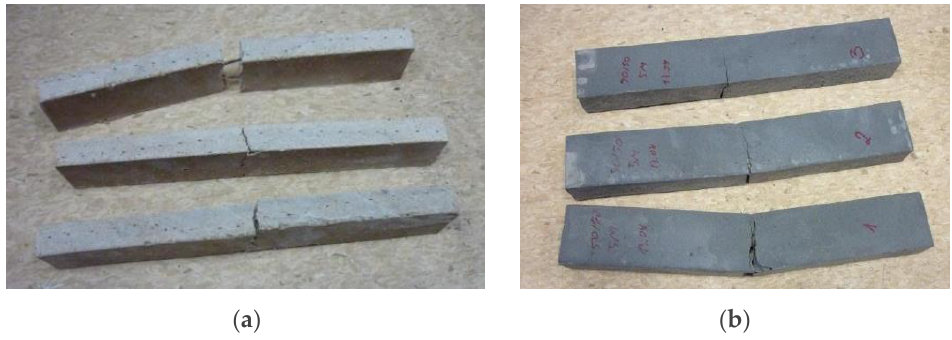
Figure 18. Geopolymer samples after the flexural test (5M NaOH solution): ( a ) metakaolin + sand + 1 layer of basalt grid; ( b ) fly ash + sand + 1 layer of basalt grid .